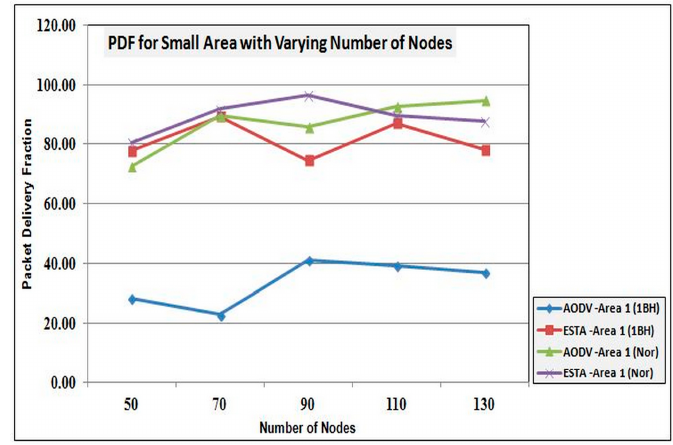
Figure 13. PDF for varying nodes in a small